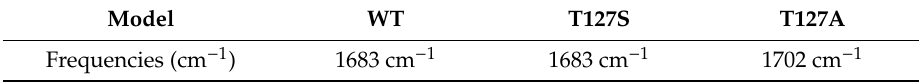
Table 3. Calculated vibrational frequencies of the C = N–H vibration using the QM / MM method.